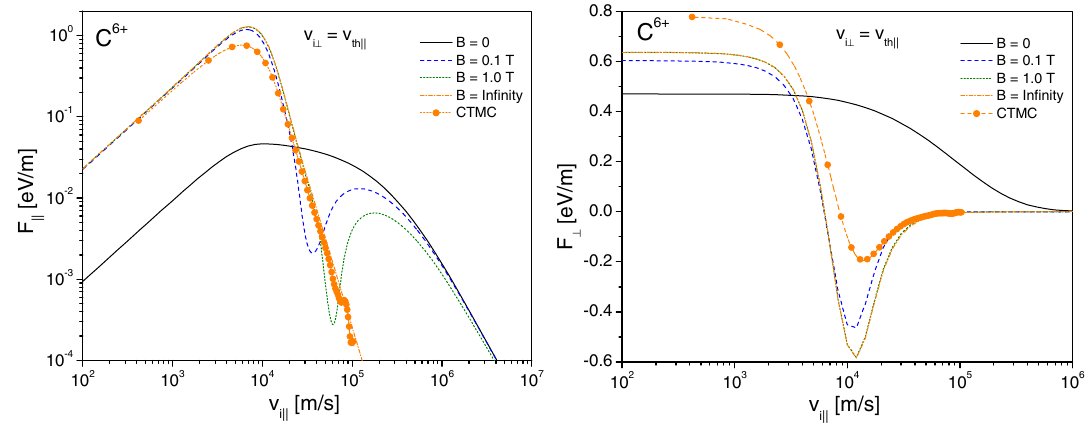
¼ v th k . Notethatintherightpanelthetransverseforcefor B i ?